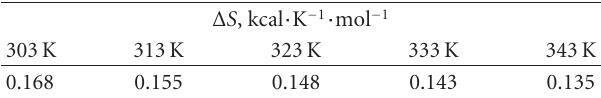
Table 8: The change in entropy ( Δ S ) for mild steel in 1.0M HCl in the presence of 3-benzoylmethyl benzimidazolium hexafluoroanti- monate (BMBI) inhibitor at various temperatures (303